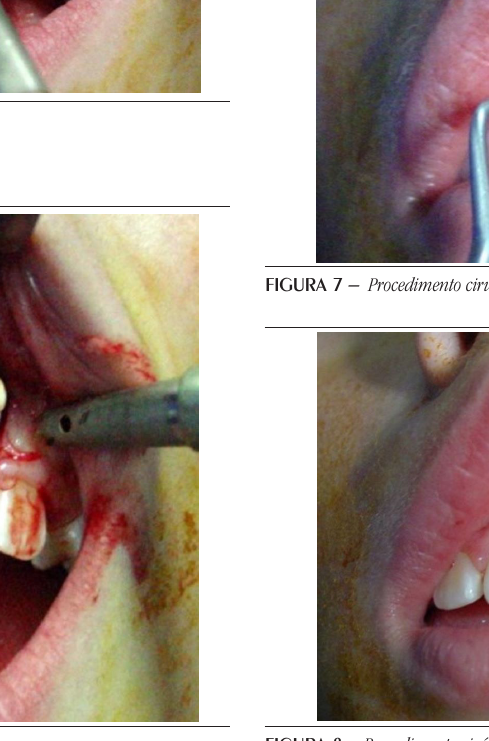
FIGURA 8 – Procedimento